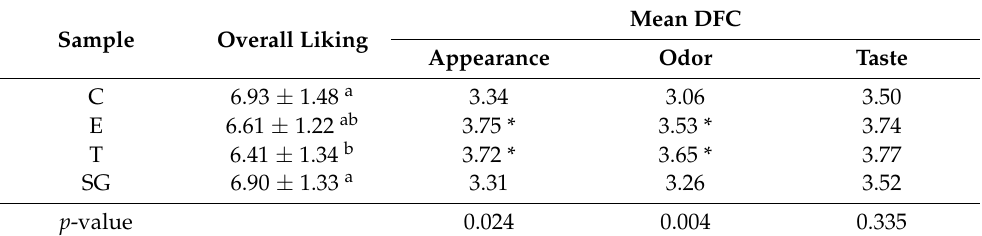
Table 3. Overall liking score and difference from control (DFC) test